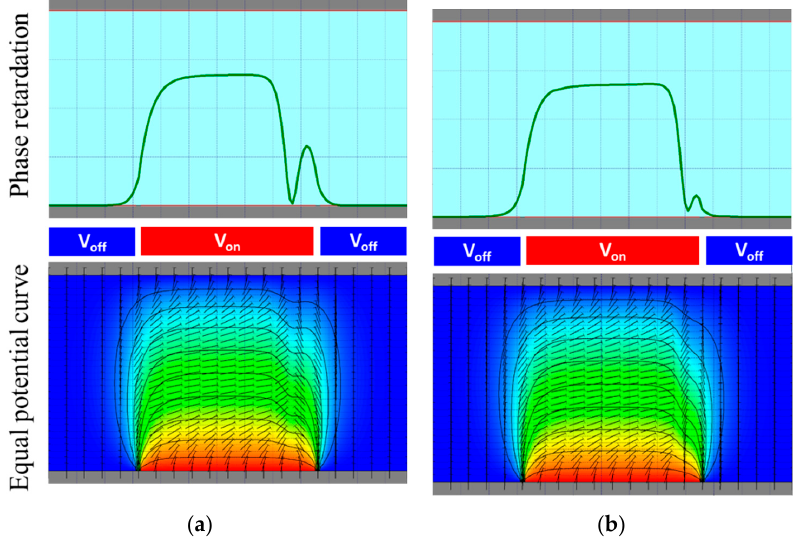
Figure 8. The pixel location dependent phase retardation curve and equal potential curve with ( a ) even pretilt angle distribution and ( b ) specially-designed uneven pretilt angle distribution.